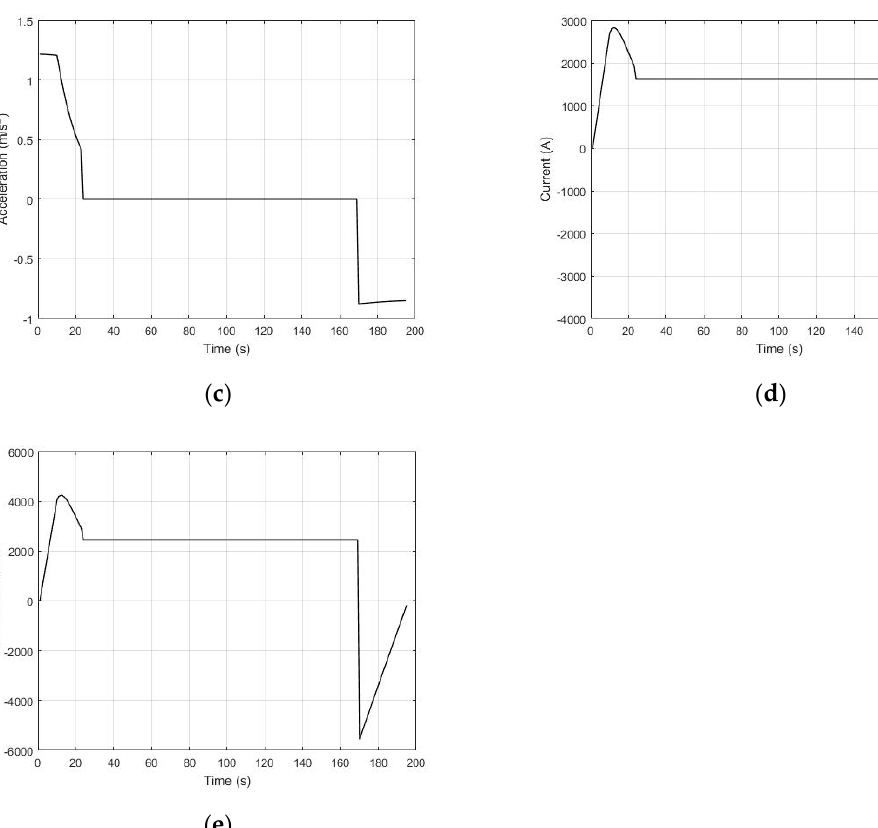
Figure 10. Traction calculation results of the train during running process: ( a ) speed–time curve; ( b ) distance–time curve; ( c ) acceleration–time curve; ( d ) current–time curve; and ( e ) active power–time curve.